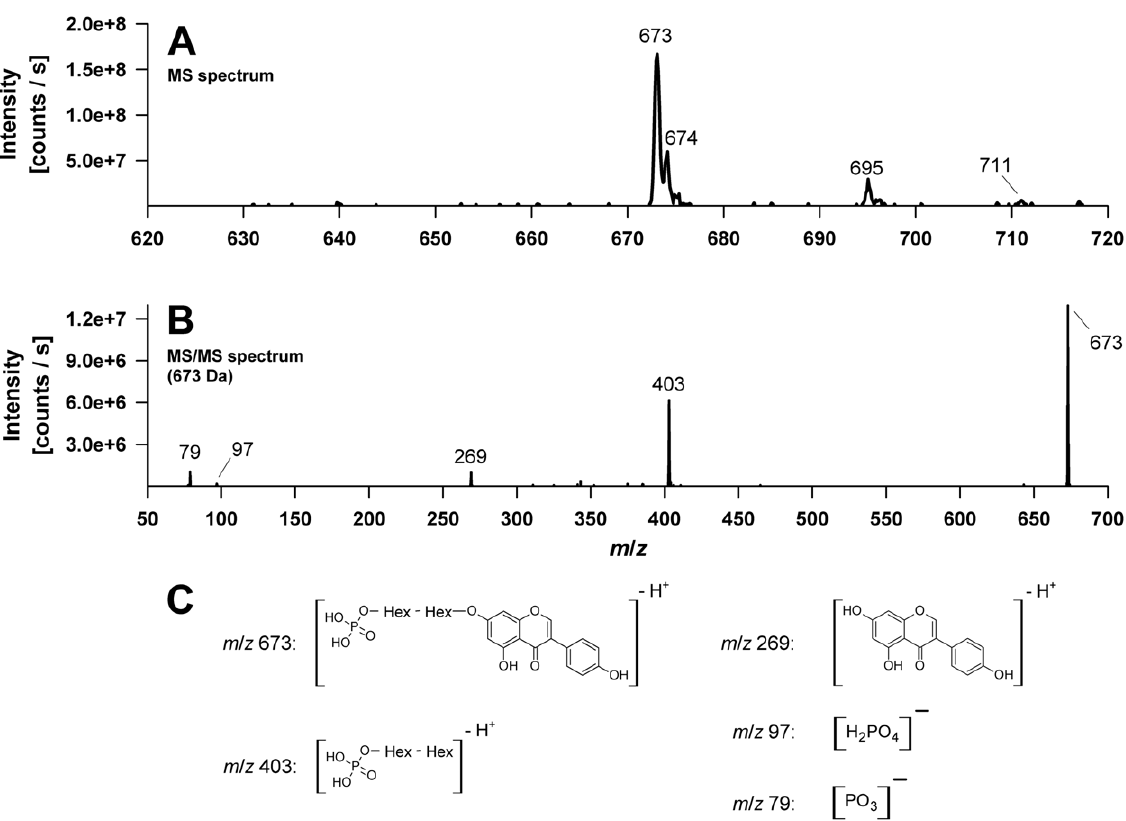
Figure 6. Electrospray mass spectra (QTrap system) of the deprotonated genistein metabolite M4 assigned as a genistein- phosphodisaccharide. (A) MS spectrum. (B) MS/MS spectrum of m/z 673. (C) Proposed structures of the product ions observed in the MS/MS spectra. Hex, Hexose.